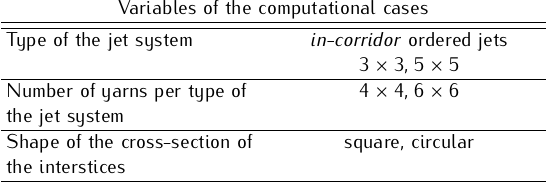
Table 1. Computational cases.